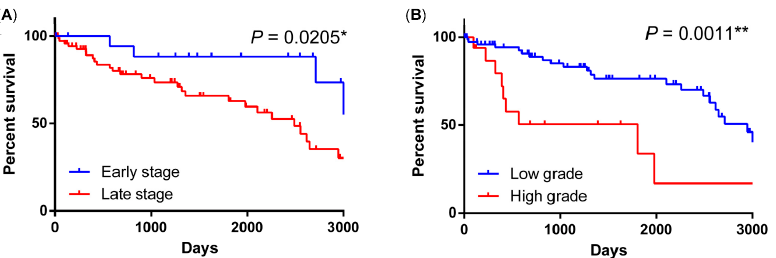
Figure 5. Overall survival with different stage and tumor grade in pre-crozotinib stage. ( A ) Late stage showed a significant worse outcome. ( B ) High tumor grade also indicated a poor prognostic value. * p < 0.05, ** p < 0.01.